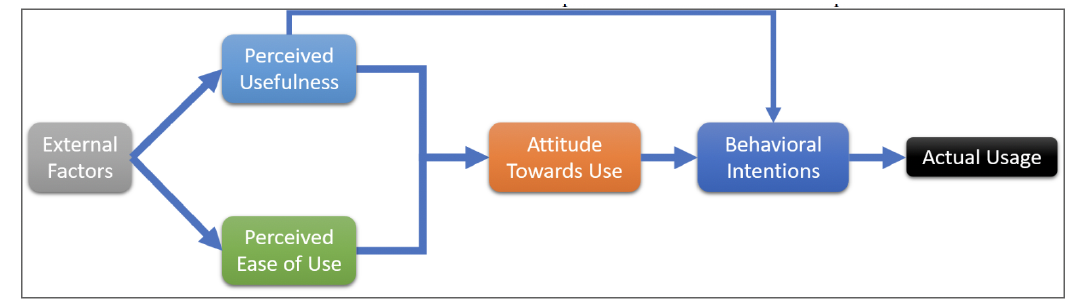
Figure 1. The technology acceptance